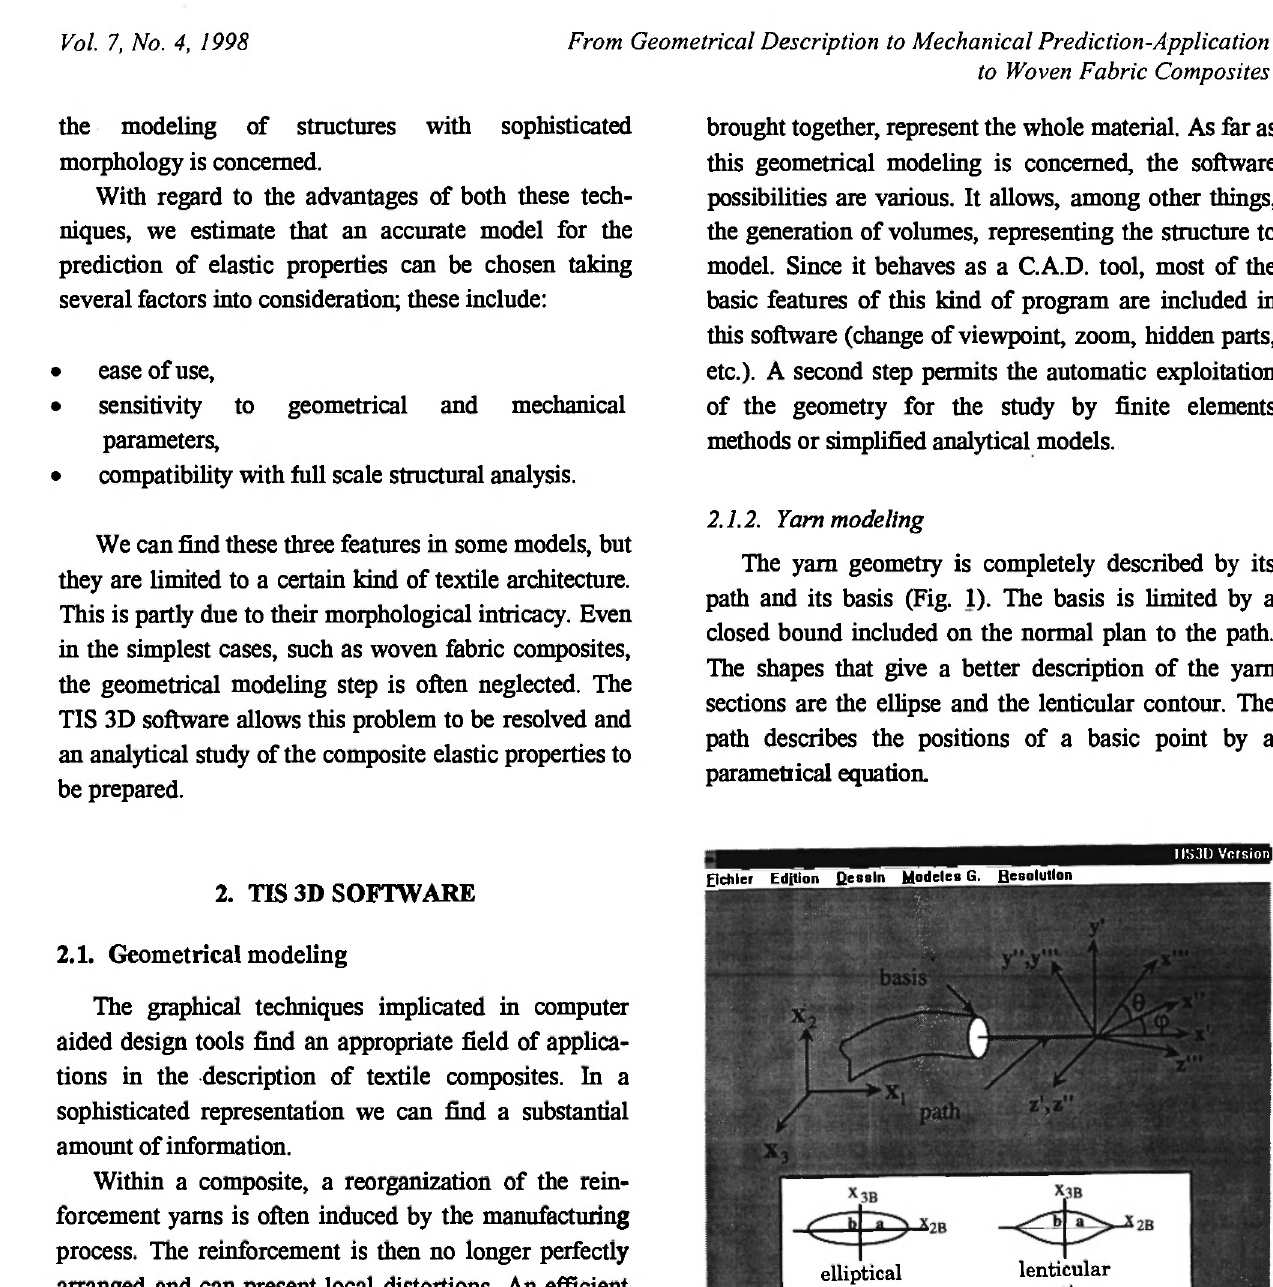
x3) local axis, 2